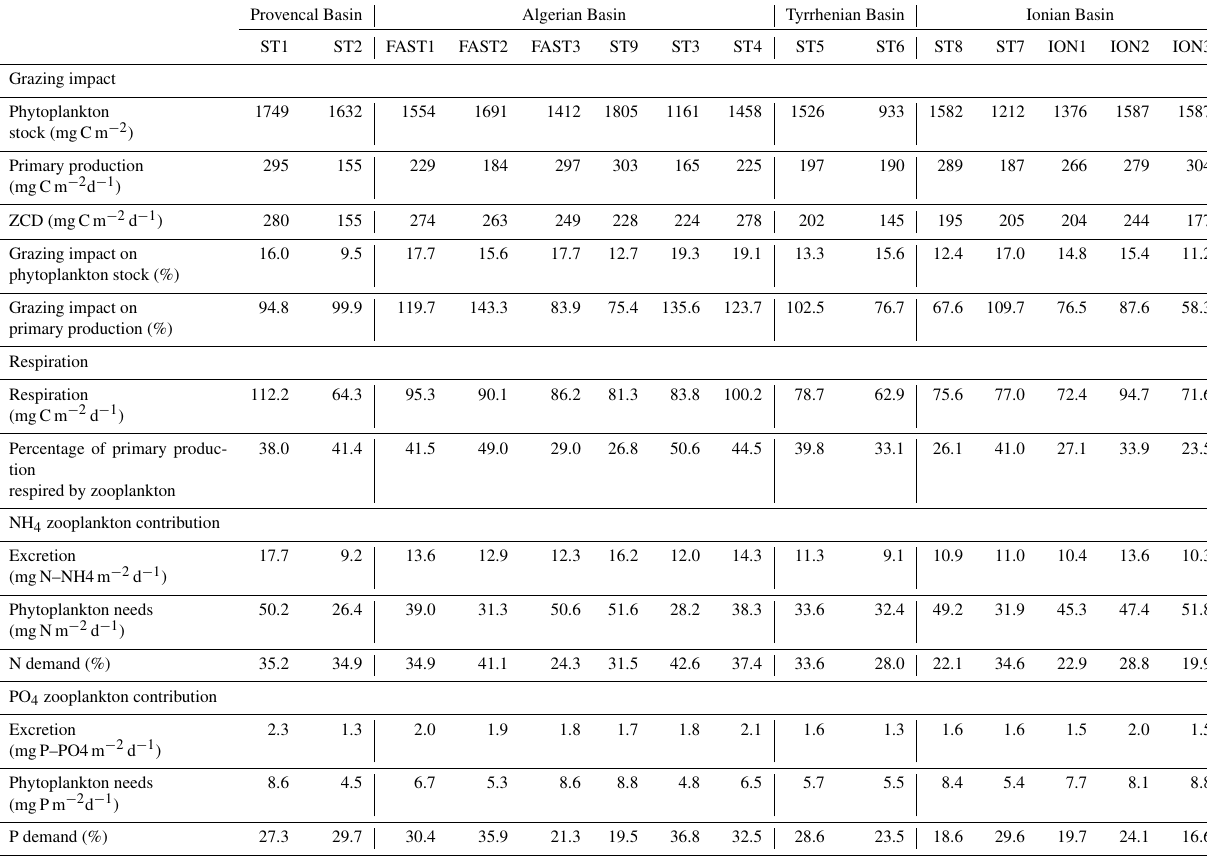
Table 6. Estimated grazing, respiration, and excretion rates of zooplankton based on allometric models (see Sect. 2) and their impact on the phytoplankton stock and production along the PEACETIME survey